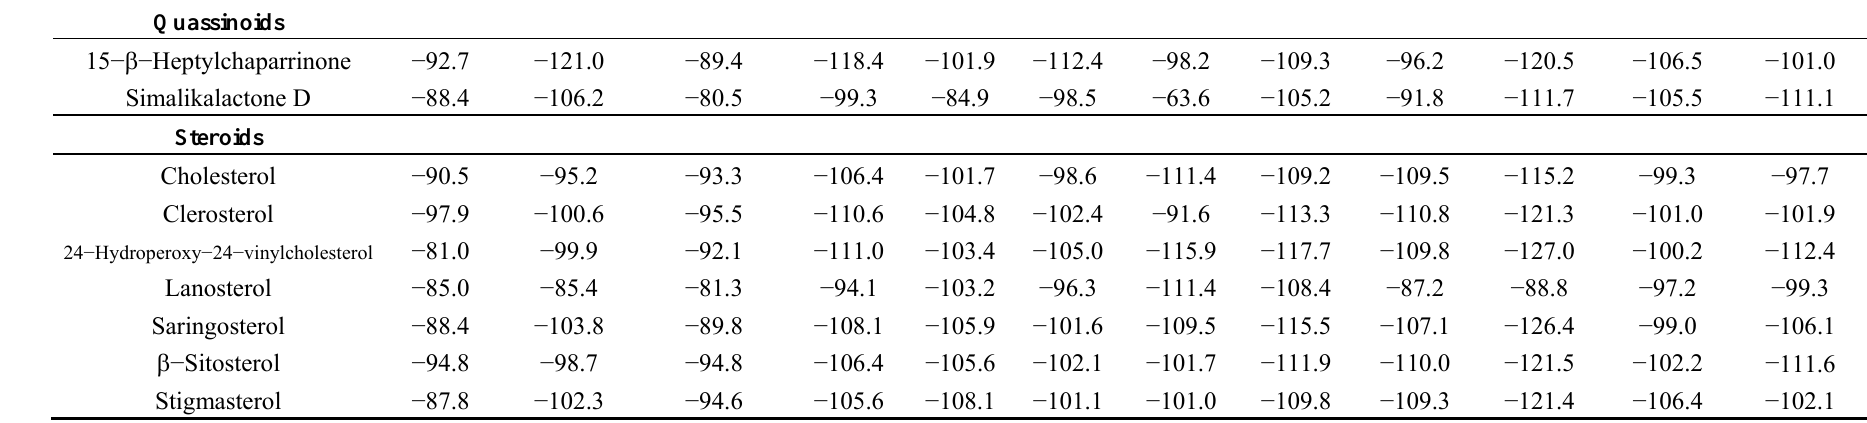
Table 38. MolDock docking energies (kJ/mol) of quassinoids and steroids with Leishmania major protein targets.